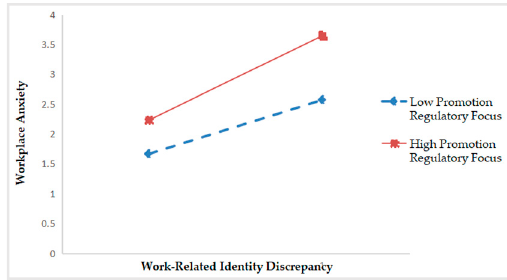
Figure 2. Moderation effect of promotion regulatory focus.